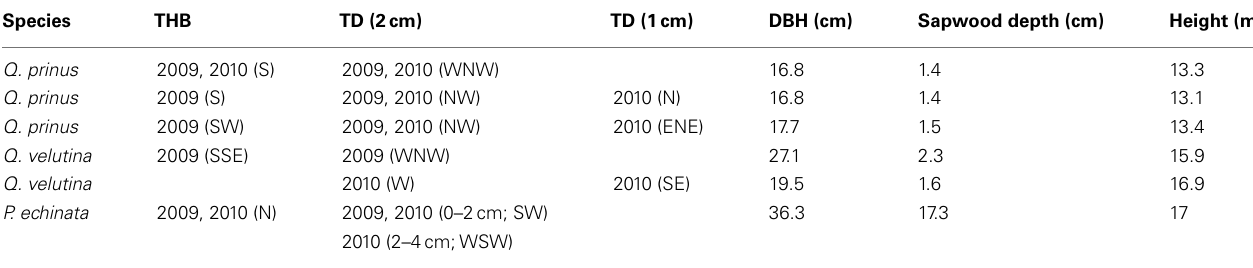
Table 1 | Biometric data for trees receiving tissue heat balance (THB) and thermal dissipation (TD) sensors. Species THB TD (2cm) TD